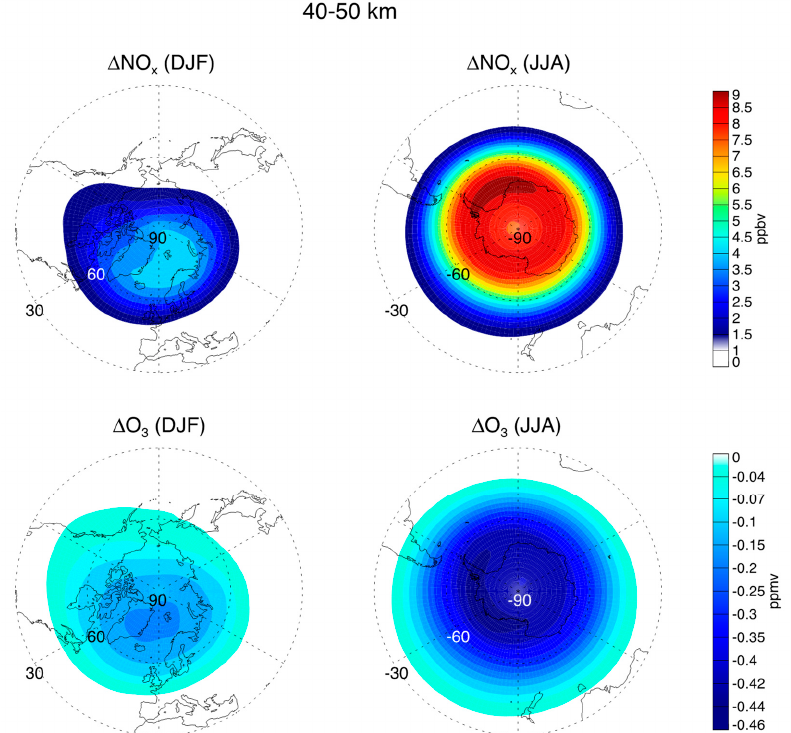
Figure 5. The differences (MEE-Control) of the mean NOx and ozone are presented in the altitude range of 40–50 km in the northern winter (December, January, February; DJF) and southern winter (June, July, August; JJA) during the period from 2005 to 2013.